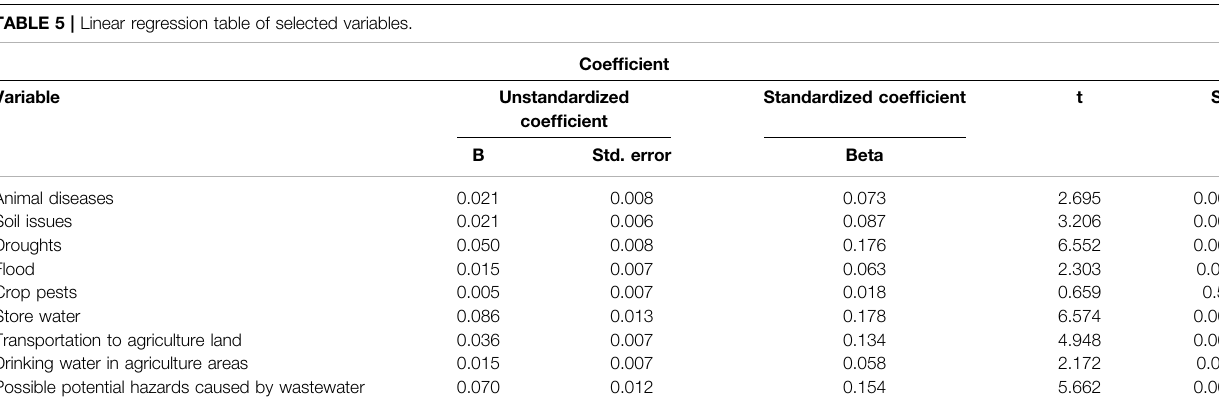
TABLE 5 | Linear regression table of selected